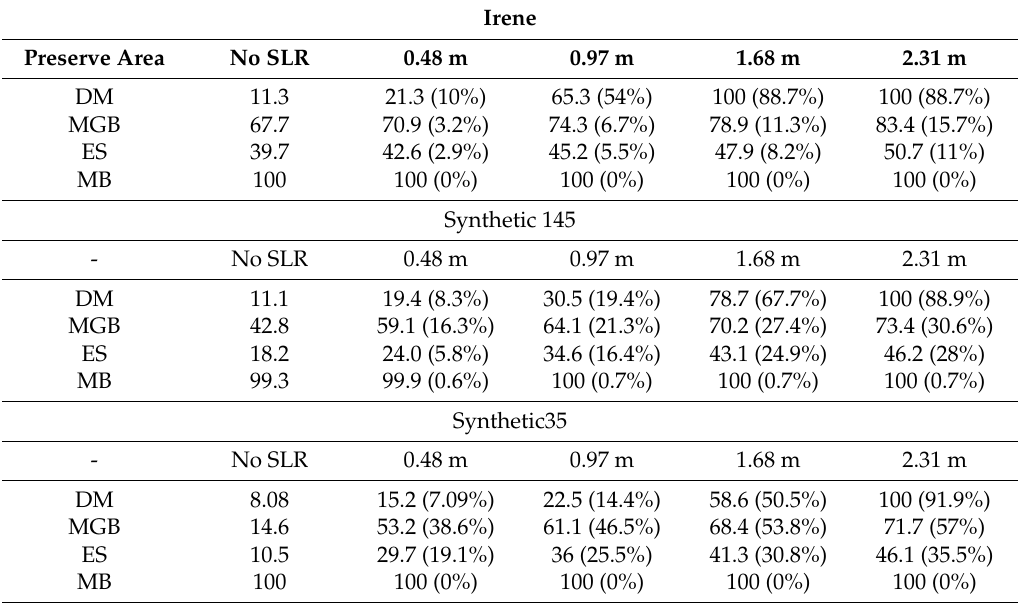
Table A2. The percent of inundated land area for each marsh and the percent increase in flooded area shown in parenthesis.